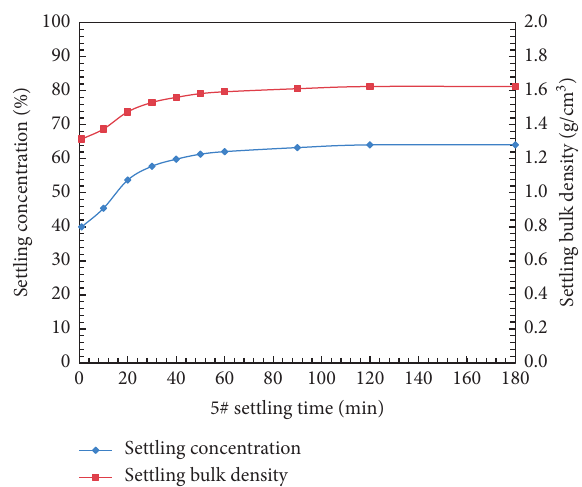
Figure 12: Variation curves of flocculation settling concentration and bulk density